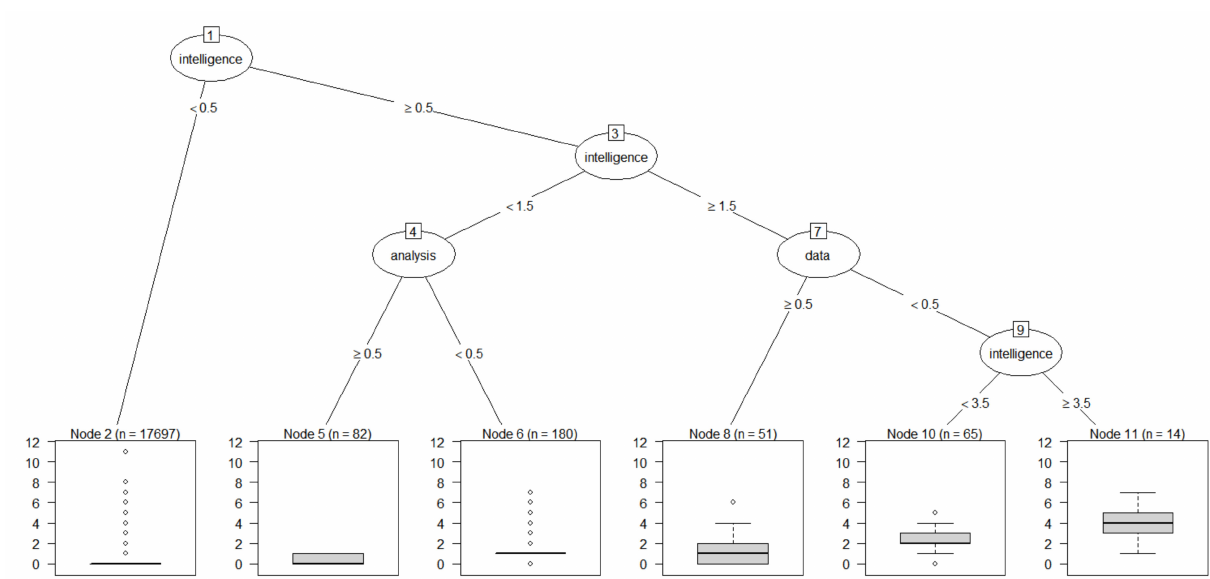
Figure 6. Regression tree plot of